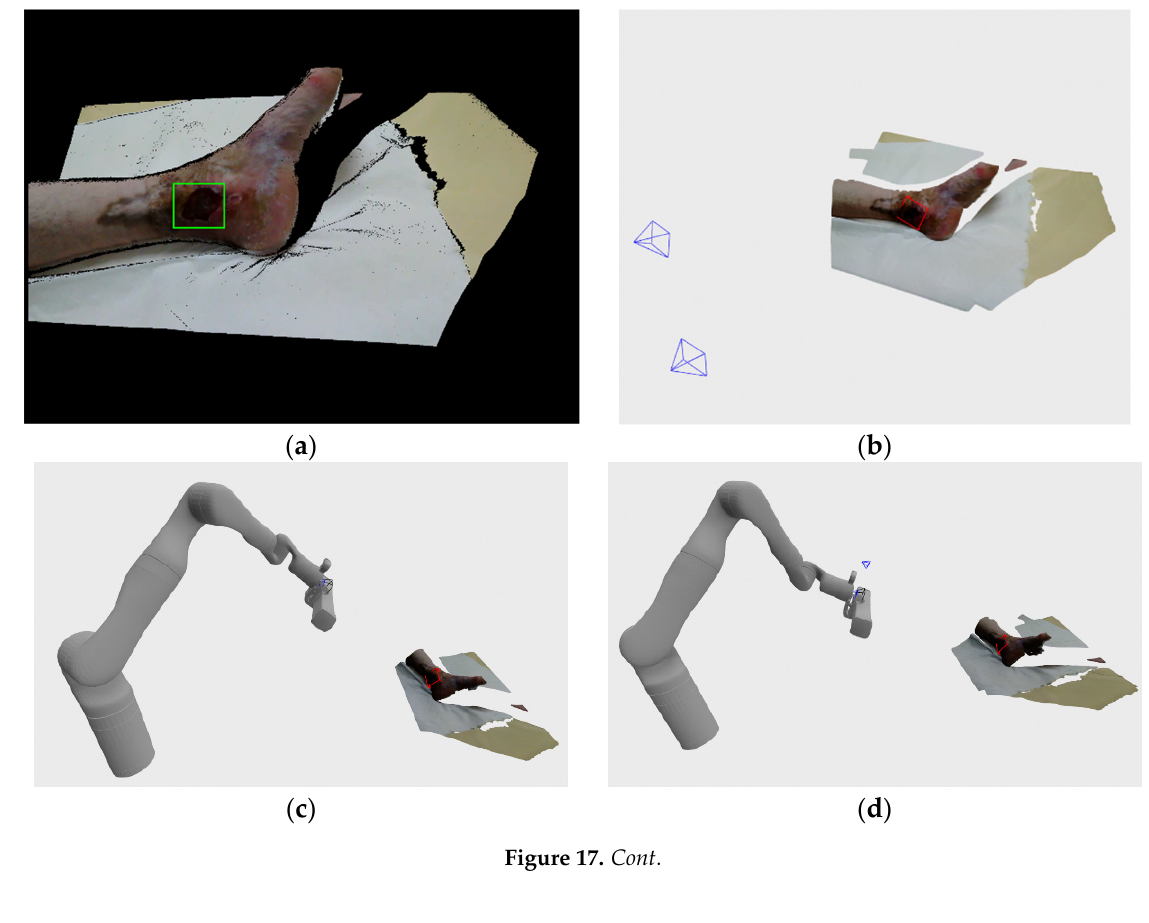
Figure 16. Recording of stage IV pressure ulcer medical wound model: ( a ) wound detection at initial recording position; ( b ) recording poses relative to the recorded wound; ( c ) robot position in relation to the recorded wound in first recording; ( d ) robot position in relation to the recorded wound in second recording; ( e ) robot position in relation to the recorded wound in third recording; ( f ) robot position in relation to the recorded wound in fourth recording; ( g ) final reconstructed 3D model; ( h ) final reconstructed 3D model with normal map